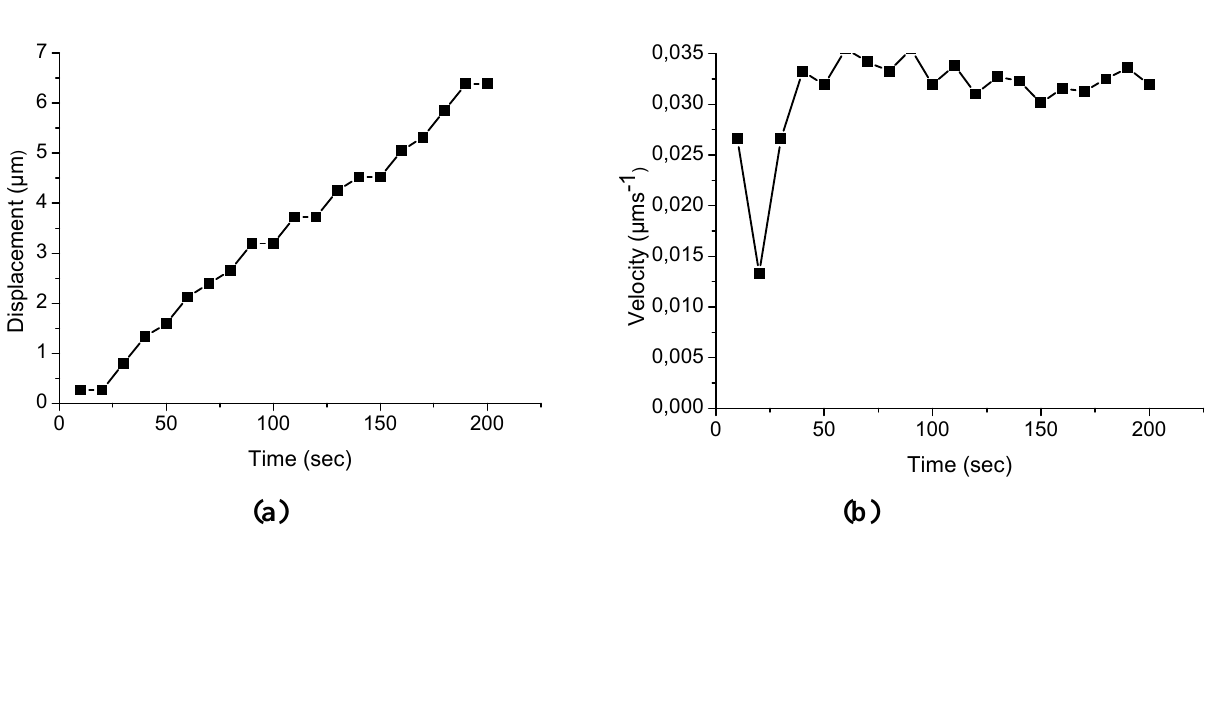
Figure 11. Displacement vs time graphs for RH changes, (a, top left) 75% to 45% and (c, bottom left) 10% to 45%, velocity vs time graphs for RH changes (b, top right) 75% to 45% and (d, bottom right 10% to